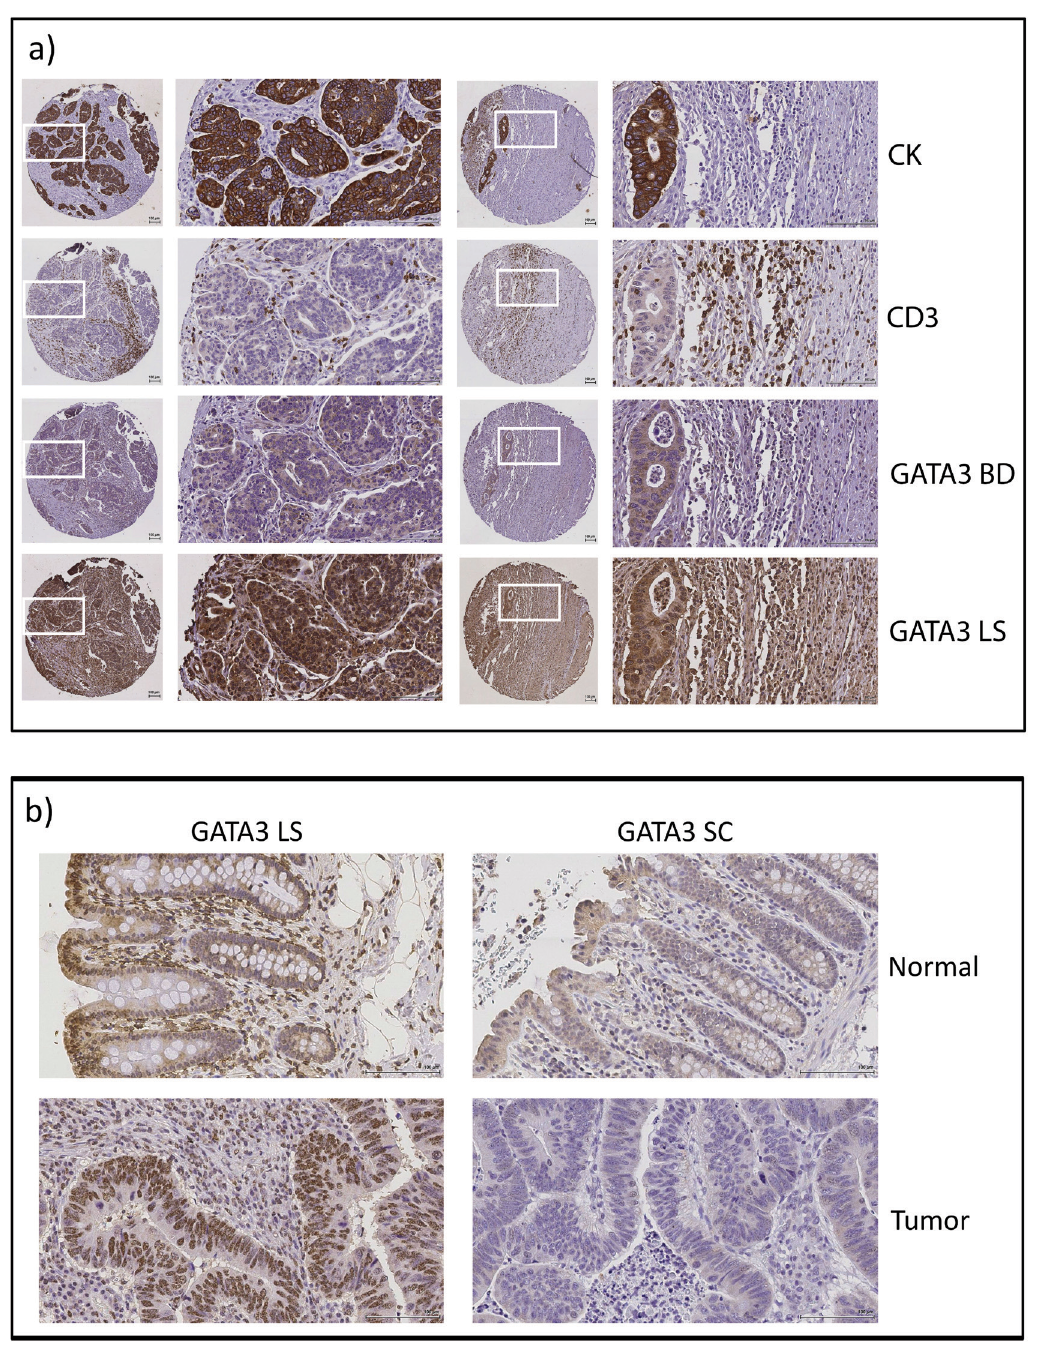
Figure 4. GATA3 is expressed in human CRC. a ) Representative immunostained tissue sections from two patient tumors from the CRC TMA showing staining for epithelial tumor (cytokeratin, CK), T-cells (CD3), and two different GATA3 antibodies (BD and LS). b ) Representative staining of matched normal colonic tissue and colon cancer samples for two different GATA3 antibodies (LS and SC). Note the variability of GATA3 staining with different antibodies.